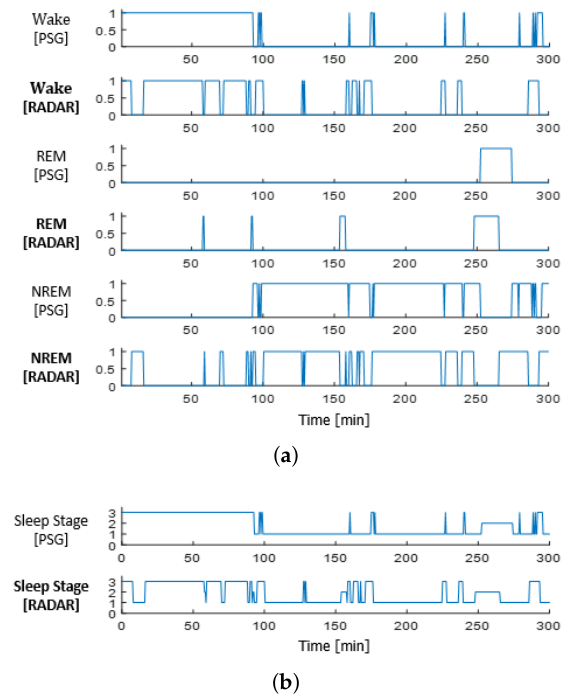
Figure 8. Labeling in sleep-stage-detection results. ( a ) Sleep-stage-detection results before labeling. ( b ) Sleep-stage-detection results after labeling. Table 2. Sleep-stage-detection